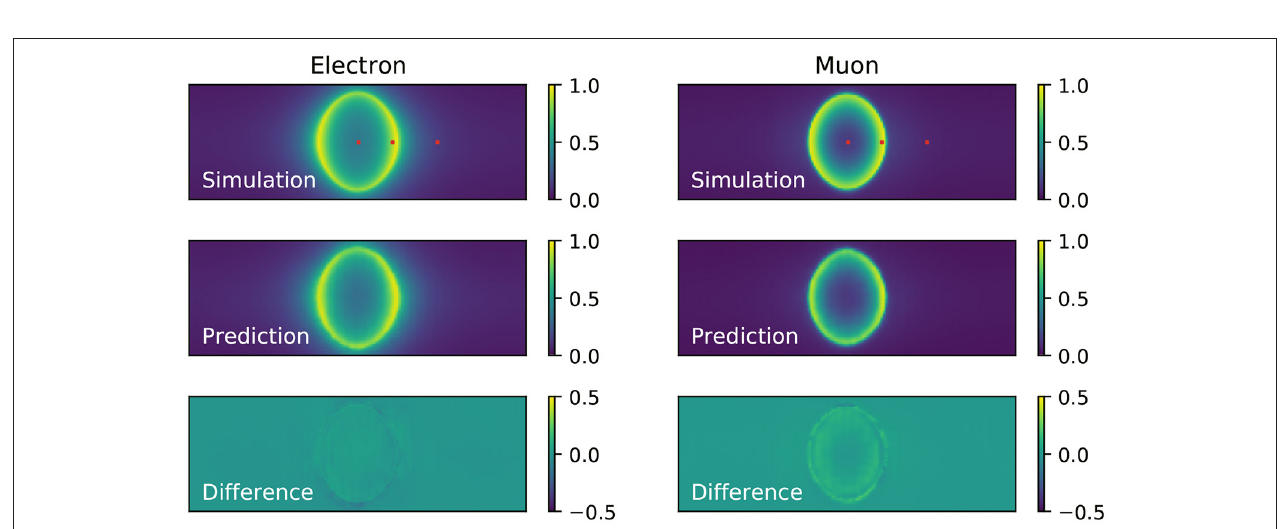
FIGURE 3 | Neural network training curves. The loss is shown as a function of training epoch for 1, 3, 5 and 10 component charge-only (left) , uncorrelated charge and time (middle) , and correlated charge and time likelihoods (right) . The solid lines correspond to the loss evaluated on a validation sample, and the dotted lines correspond to the loss evaluated using the training sample.